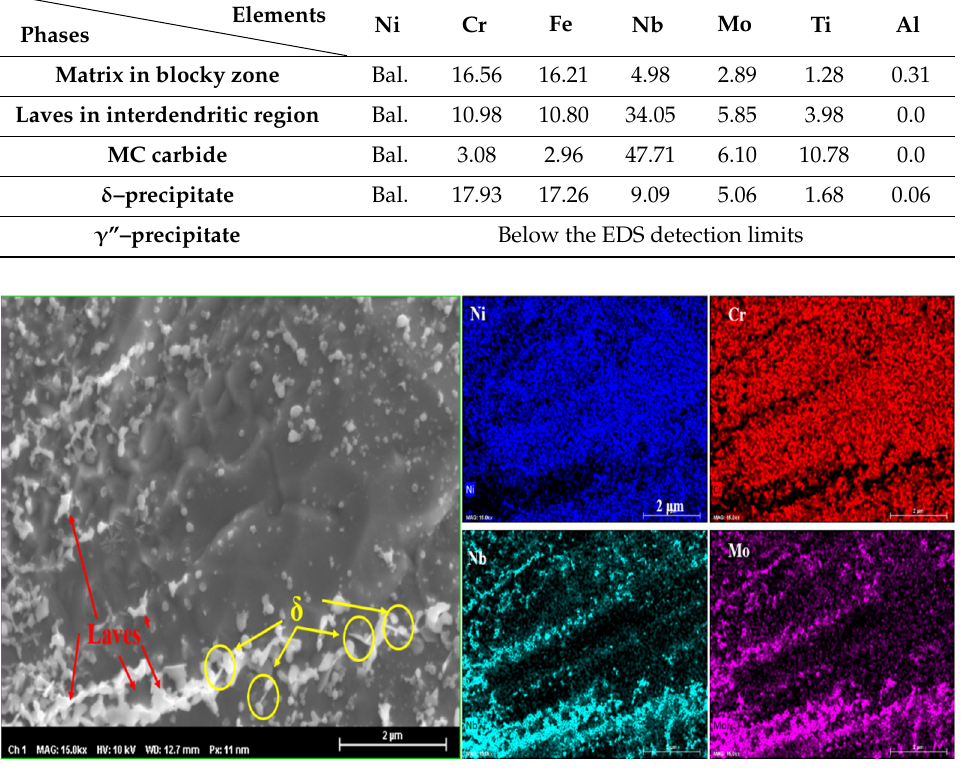
Figure 13. Chemical EDS mapping of some principal elements of as-SLM IN718 sample heated to 1000 °C for 200 °C/s.